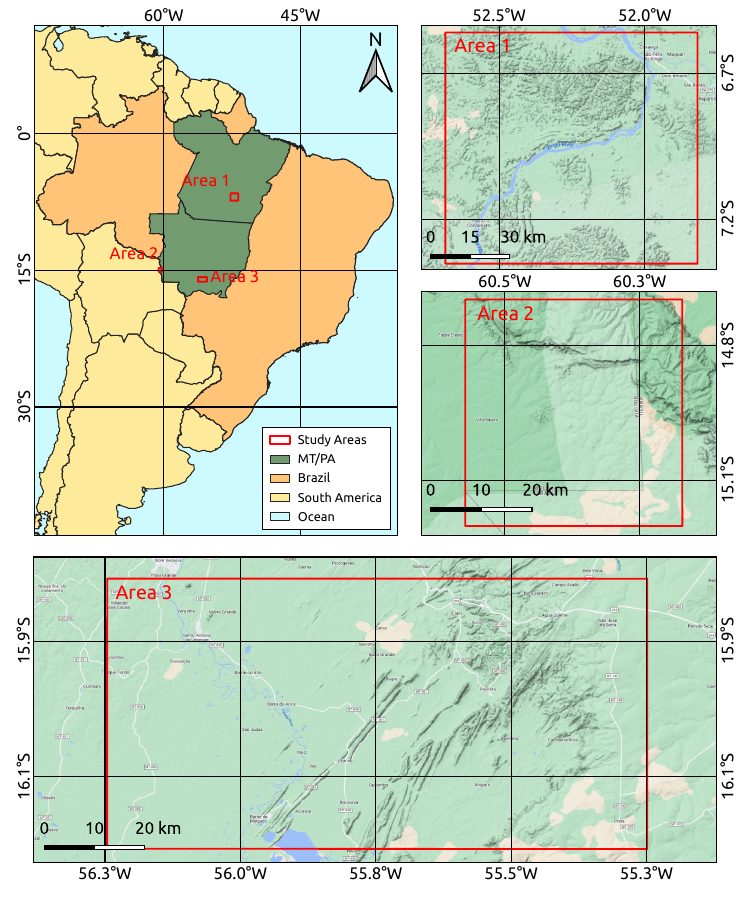
Figure 2. Study area